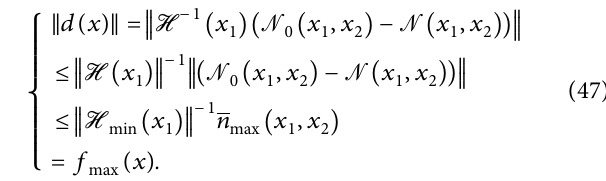
Figure 15: Tracking errors of q